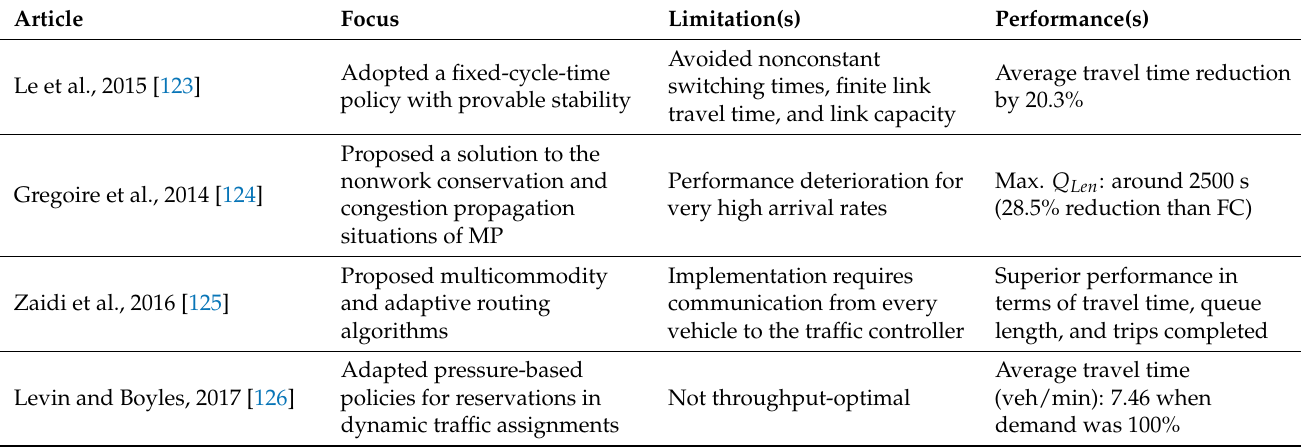
Table 21. Summary of the works found related to